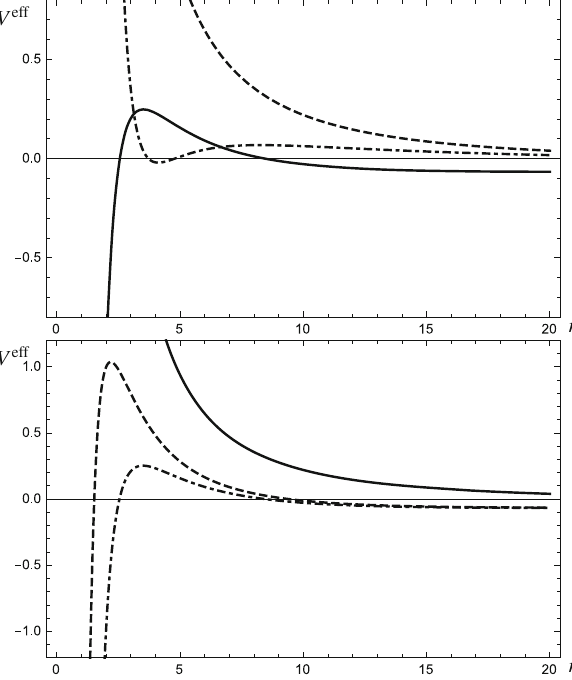
Fig. 1 Top panel Comparison of the effective potential between two models of the Bonnor solution ( dashed line with h = − 0 . 000214 and dot-dashed line with h = − 10) with the Schwarzschild case ( continu- ousline )with M = 1.Chosenvaluesforenergyandangularmomentum √ are E = 1 . 01 and L = 24. Bottom panel Comparison of the effective potential between the Bonnor model with h = − 0 . 000214 ( continuous line ) and Kerr solutions with M = 1 and angular momentum parameter a = 0 . 01 ( dot-dashed line ) and a = 0 . 9 ( dashed line ). Chosen values √ for energy and angular momentum are E = 1 . 01, L =